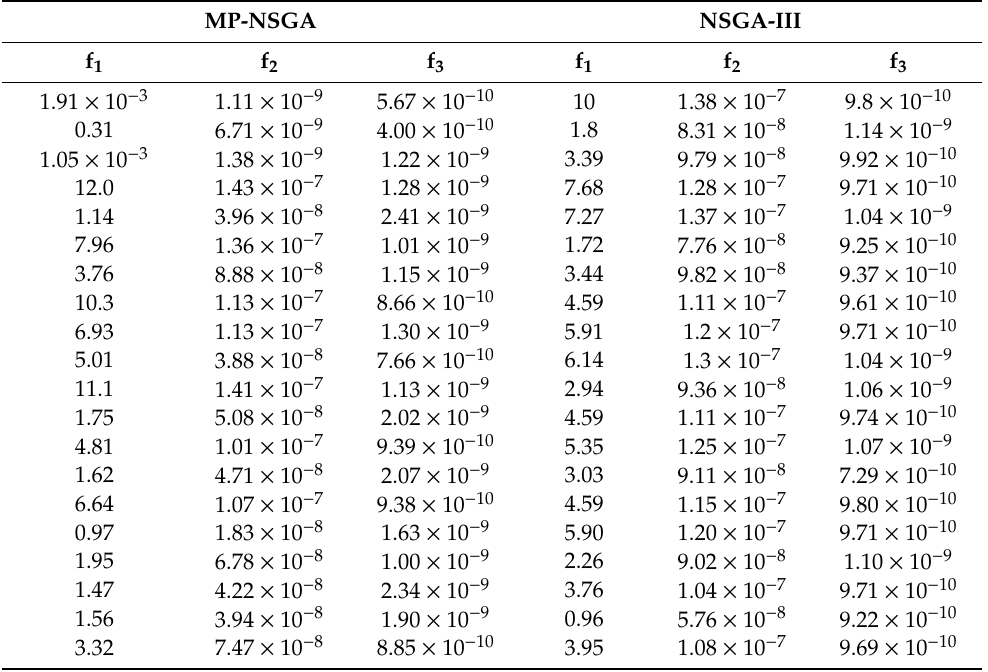
Table 2. Solutions obtained with MP-NSGA and NSGA-III.